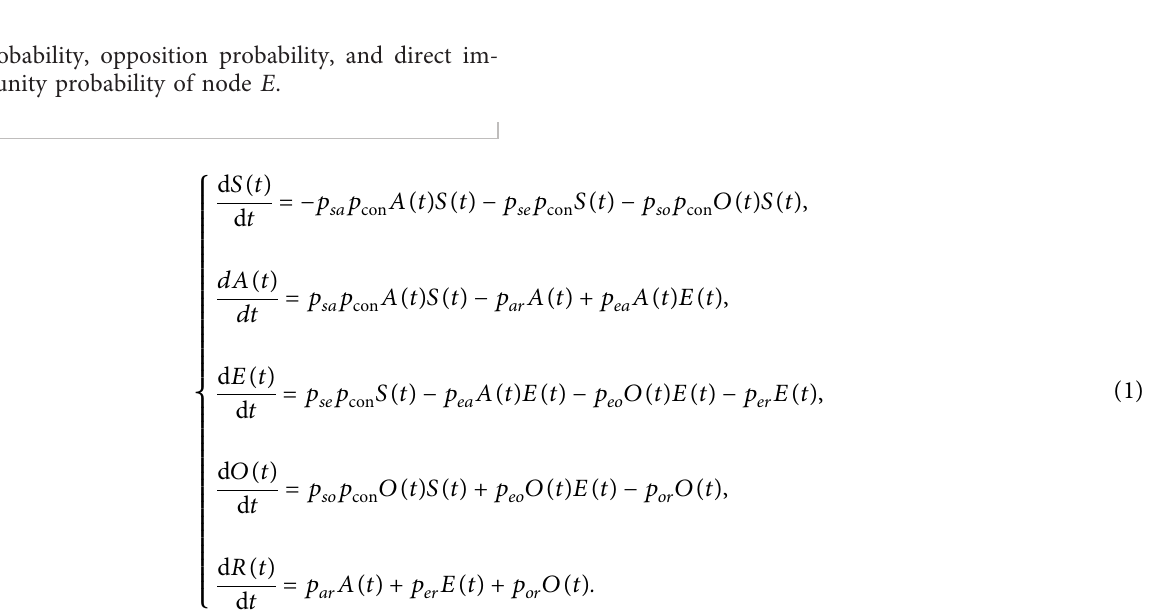
Figure 1: The state transition process of the SEAOR